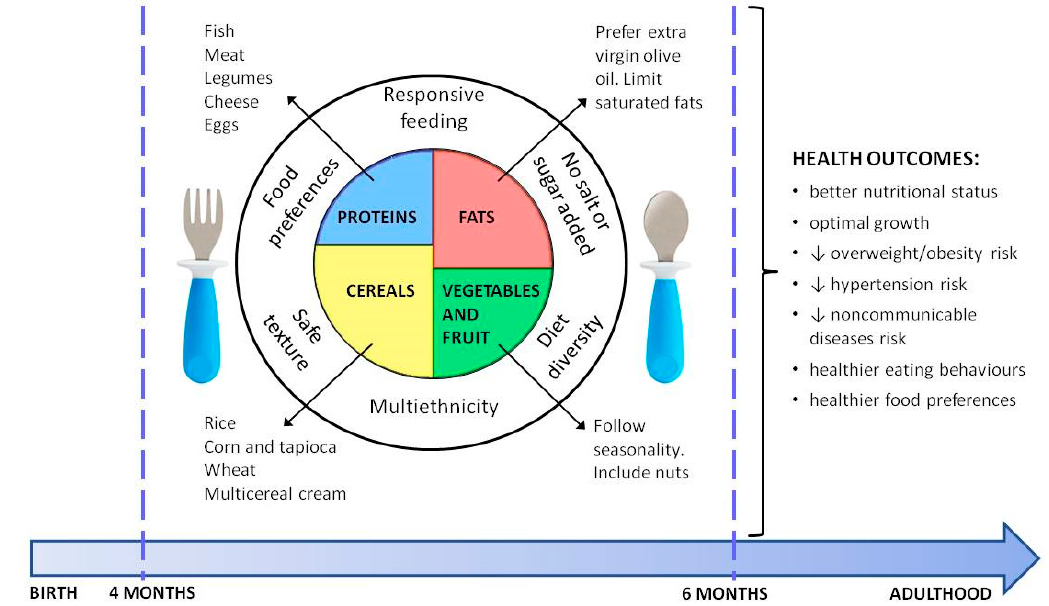
Figure 1. Suggested composition of the infant’s first meal and health outcomes.